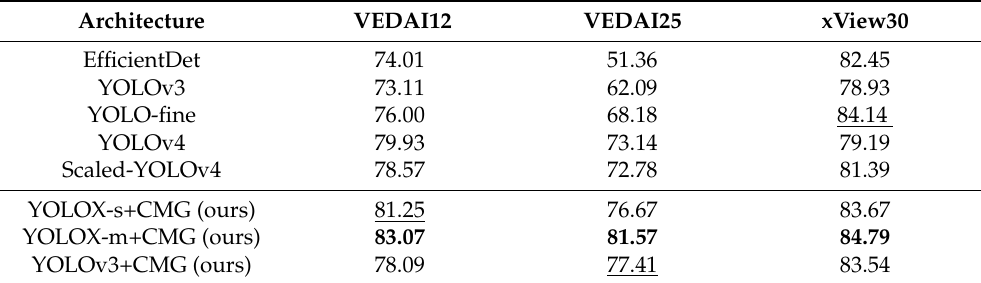
Table 5. Performance of different YOLOX backbones with CMG compared to the state-of-the-art methods. Our method outperforms or is on par with the methods designed for tiny object recognition.